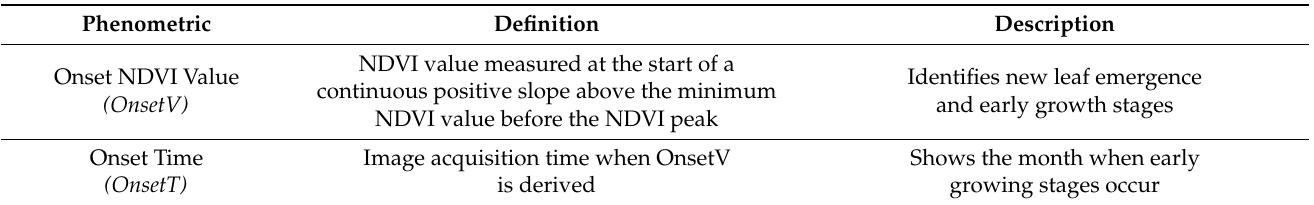
Table 3. NDVI phenology metrics computed in CropPhenology R package, adapted with permission from Araya et al.